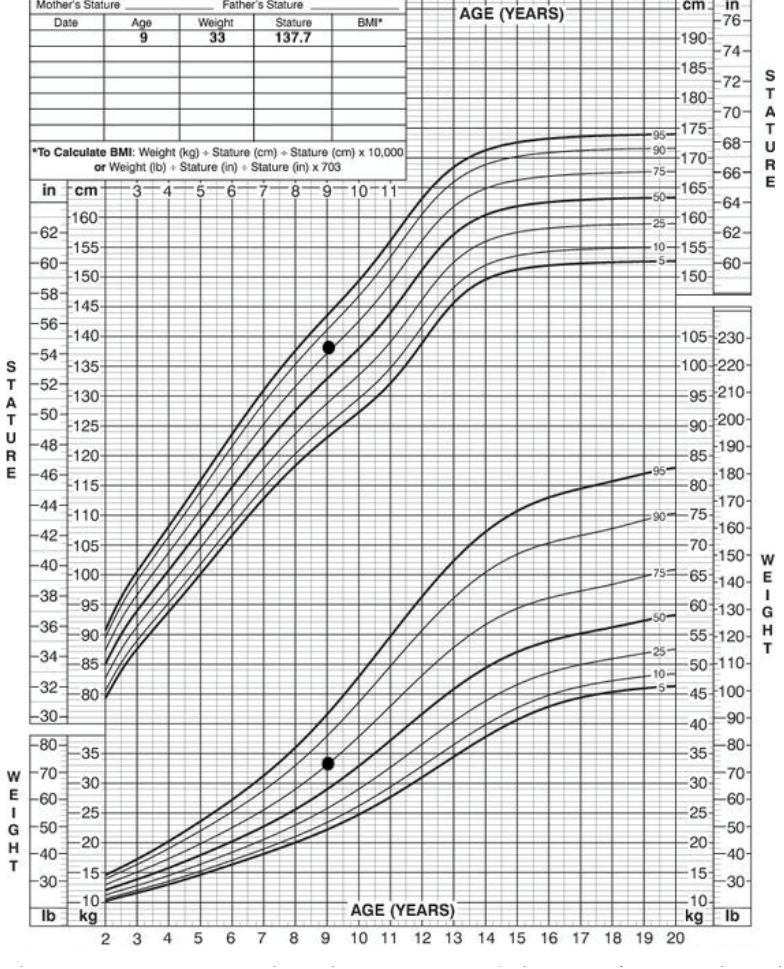
Figure 2. Patient stature and weight, 2 to 20 years: Girls stature-for-age and weight-for-age percentiles. Black marks indicate data of physical examination.